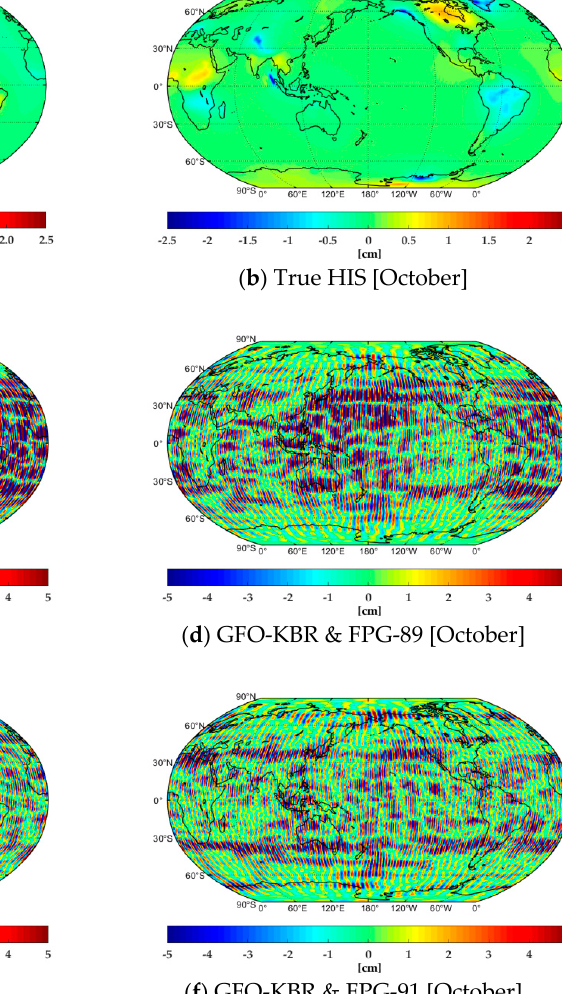
Figure 8. True monthly HIS signal spatial plots and global spatial differences plots (SDP) of GFO-KBR & FPG-89 and GFO-KBR & FPG-91 in April and October 2006: ( a ) HIS signal in April; ( b ) HIS signal in October; ( c ) SDP of GFO-KBR & FPG-89 in April; ( d ) SDP of GFO-KBR & FPG-89 in October; ( e ) SDP of GFO-KBR & FPG-91 in April; ( f ) SDP of GFO-KBR & FPG-91 in October.